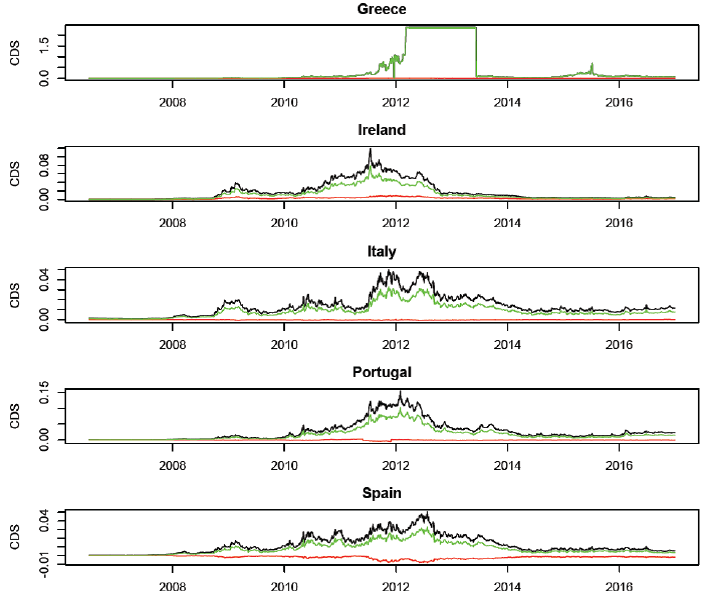
Figure 3. CoRisk and Total Risk for peripheral countries. For each considered peripheral country, the graphs report the observed CDS spreads (black line), the estimated autoregressive CDS spread components (green line) and the estimated contemporary CDS spread component ( CoRisk , red line).